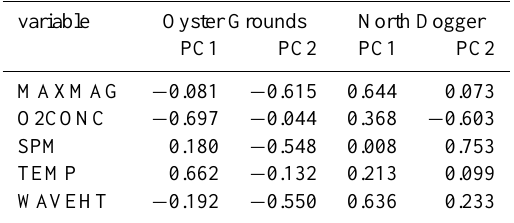
Table 2. Eigenvectors for PC1 and PC2 for Principal Components Analysis. O2CONC is oxygen concentration (mgl − 1 ) ; TEMP is temperature ( ◦ C); WAVEHT is wave height (m); MAXMAG is maximum daily average current speed (ms − 1 ) ; SPM is suspended particulate matter (mgl − 1 )